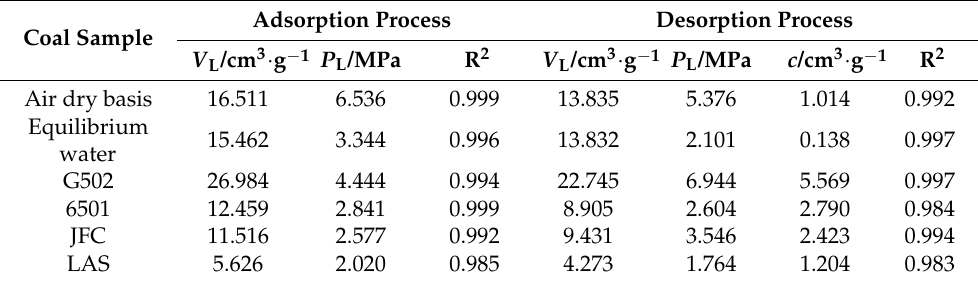
Table 12. Fitting of adsorption characteristic parameters of different wettability coal